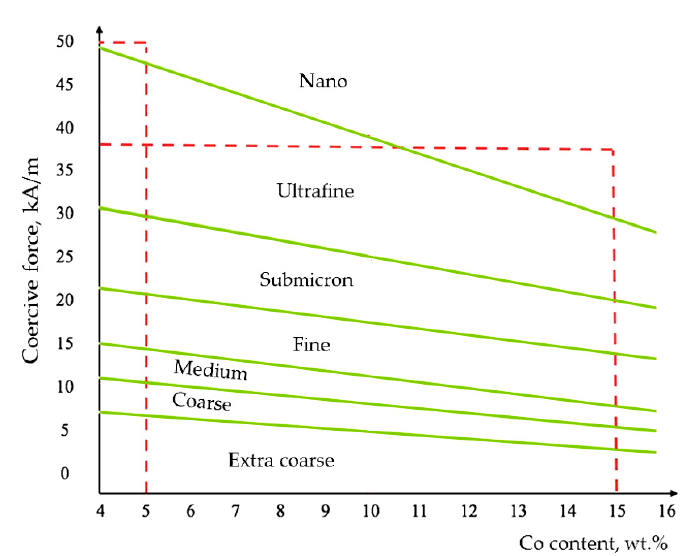
Figure 9. Influence of coercive force and Co content on the WC grain size in quality control of cemented carbides [32].